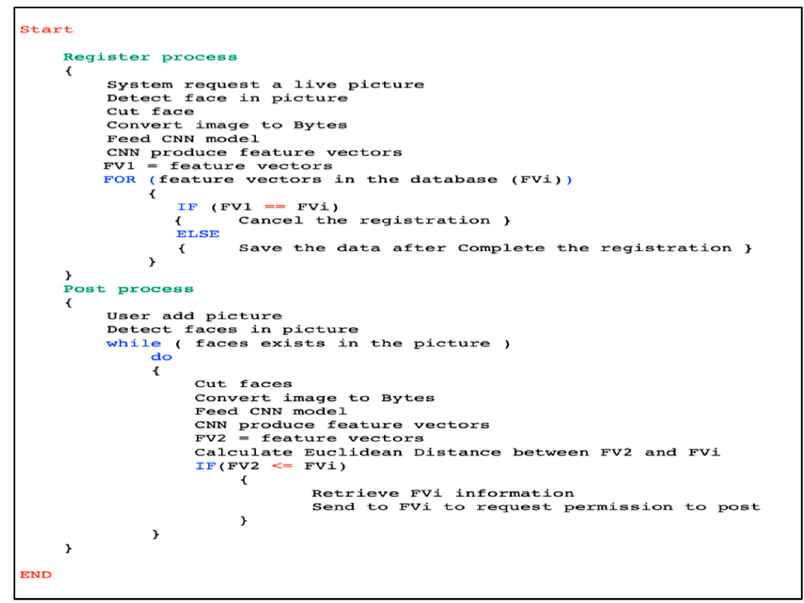
Figure 2. The Pseudo code for the proposed system.